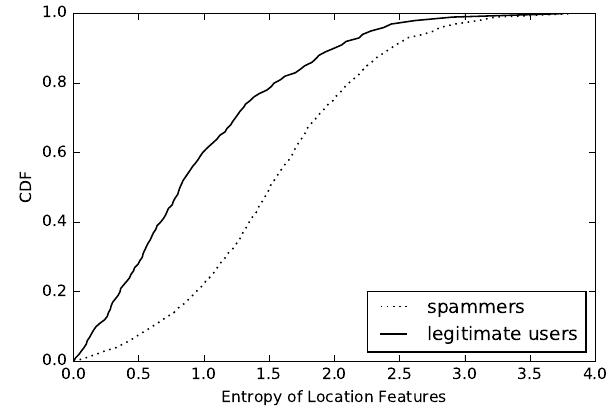
Figure 7. Entropy of location-based features.